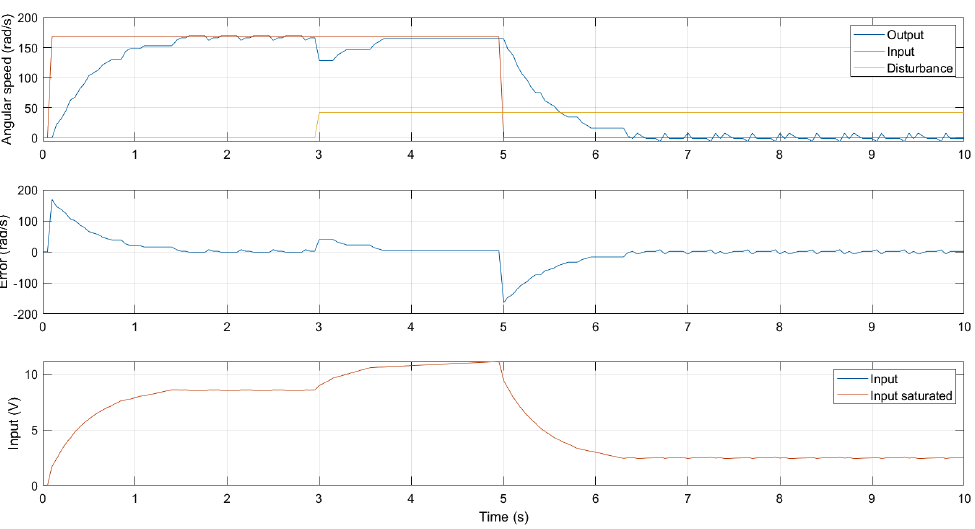
Figure 13. PI low level speed controller